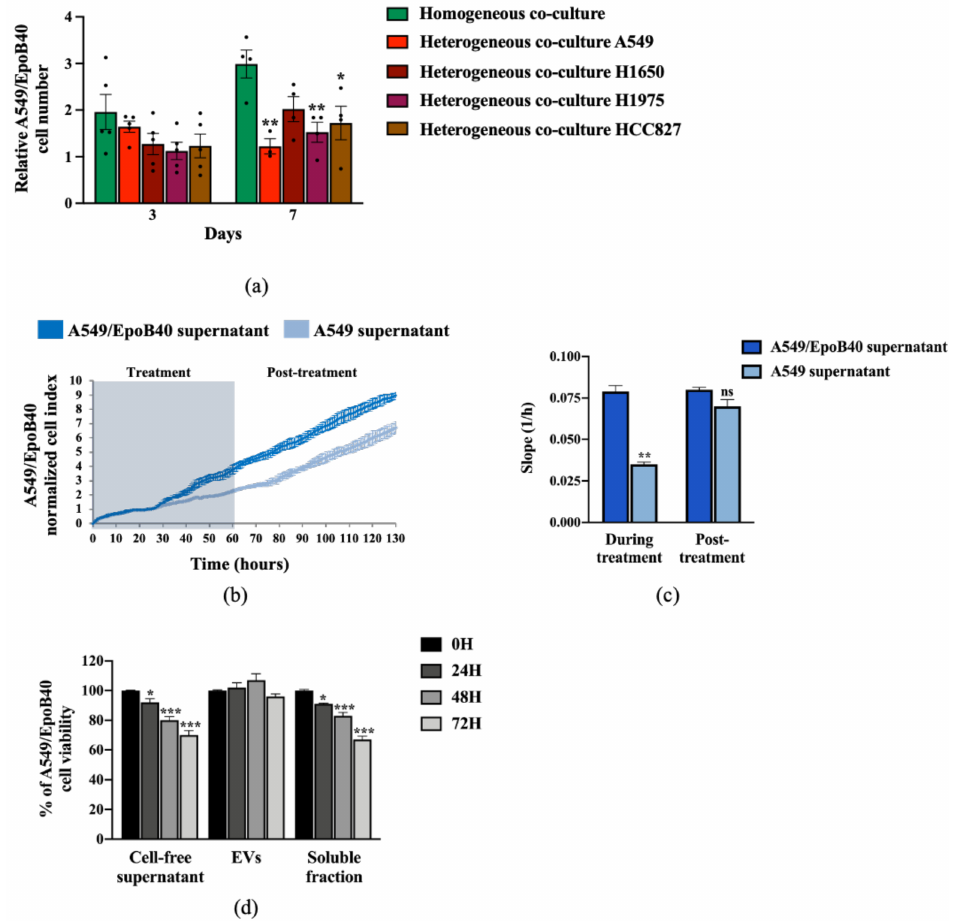
Figure 5. Drug-sensitive A549 clones control the proliferation of drug-resistant A549/EpoB40 clones through a paracrine pathway, independently of exosome secretion. ( a ) Relative quantification of A549/EpoB40 cell number in homogeneous (A549/EpoB40 only) and heterogeneous (A549/EpoB40 with either A549, H1650, H1975 or HCC827) co-culture Transwell ® . Cells were stained with crystal vi- olet at indicated times. Data were expressed as a ratio of the cell number from day 0. ( b ) A549/EpoB40 cell growth was studied by a real-time impedance-based method. Twenty-four hours after seeding, A549/EpoB40 cells were treated daily with cell-free supernatants from A549 cultures and from A549/EpoB40 cultures that were used as control. Measurements were performed every 15 min. Cell index values were normalized to 24 h, corresponding to the first measurement after starting treatment. The grey-shaded area indicates the duration of treatment. ( c ) Slopes were determined during the period of 48h supernatant treatment and 48h post-supernatant treatment. ( d ) Cell proliferation of A549/EpoB40 cells measured by crystal violet assay after a 0, 24, 48 and 72 h exposition to total cell-free supernatant, extracellular vesicles (EVs) or soluble fraction from A549 cultures. Results were expressed as a percentage of viability at T0. Data are shown as means ± SEM. ns > 0.05; * p < 0.05; ** p < 0.01; *** p <